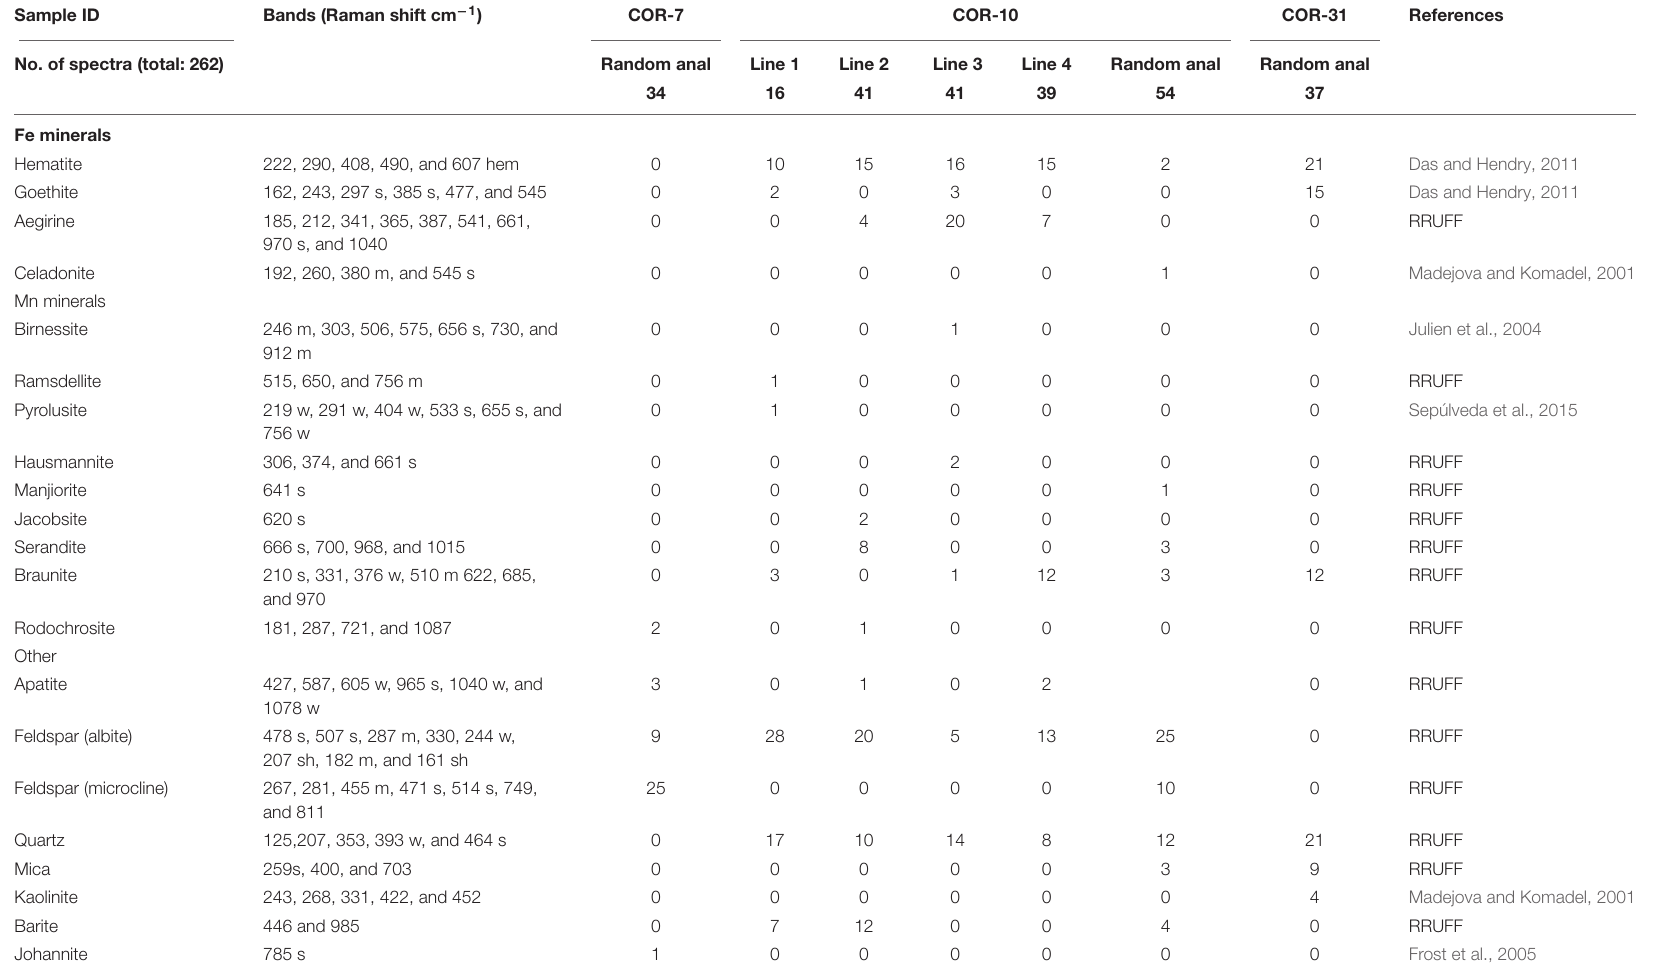
TABLE 2 | Raman vibration of minerals and detected types of organic matter. Sample